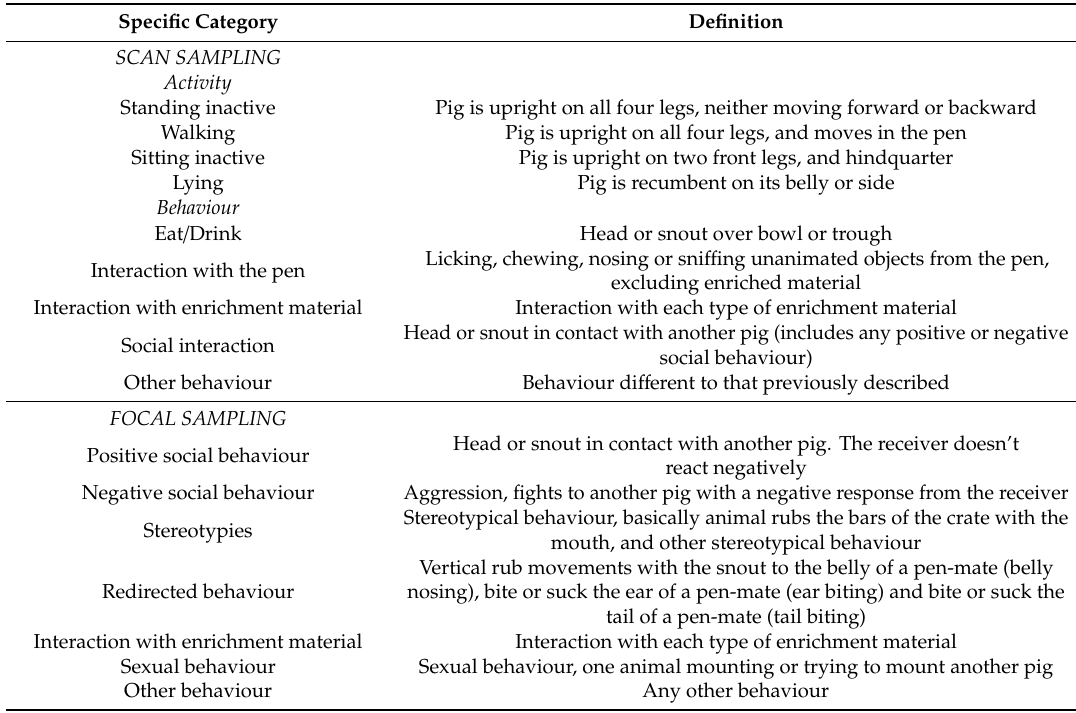
Table 1. Ethogram of the Behaviours Evaluated in the Scans or Focal Samplings taken over 12 weeks of